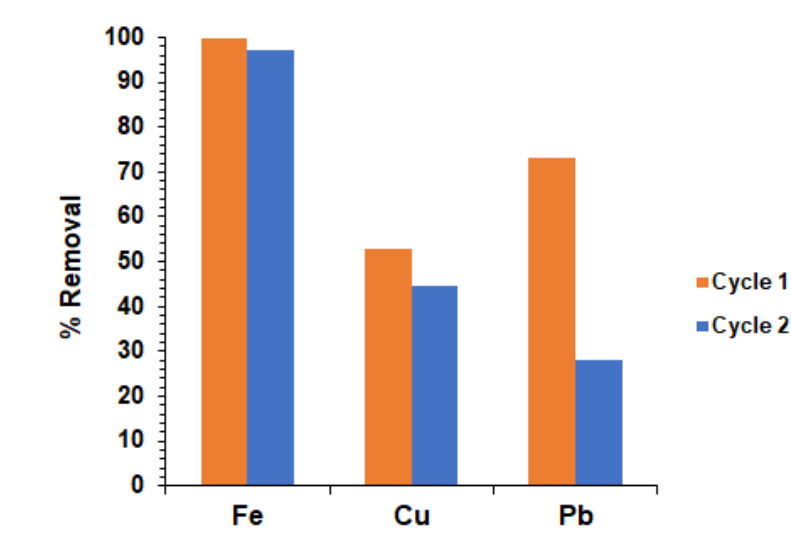
Figure 5. Regeneration capability of MXM Figure 5. regeneration capability of MXM polymer.